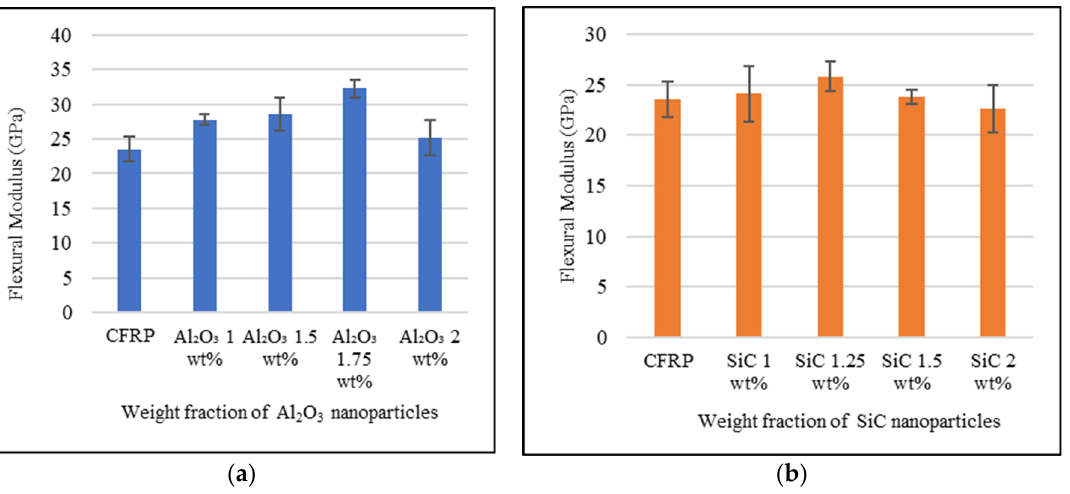
Figure 10. Flexural modulus of neat and ( a ) hybrid Al 2 O 3 and ( b ) hybrid SiC nanocomposites at various weight fractions. Table 7. Flexural behavior of neat and hybrid SiC nanocomposites.